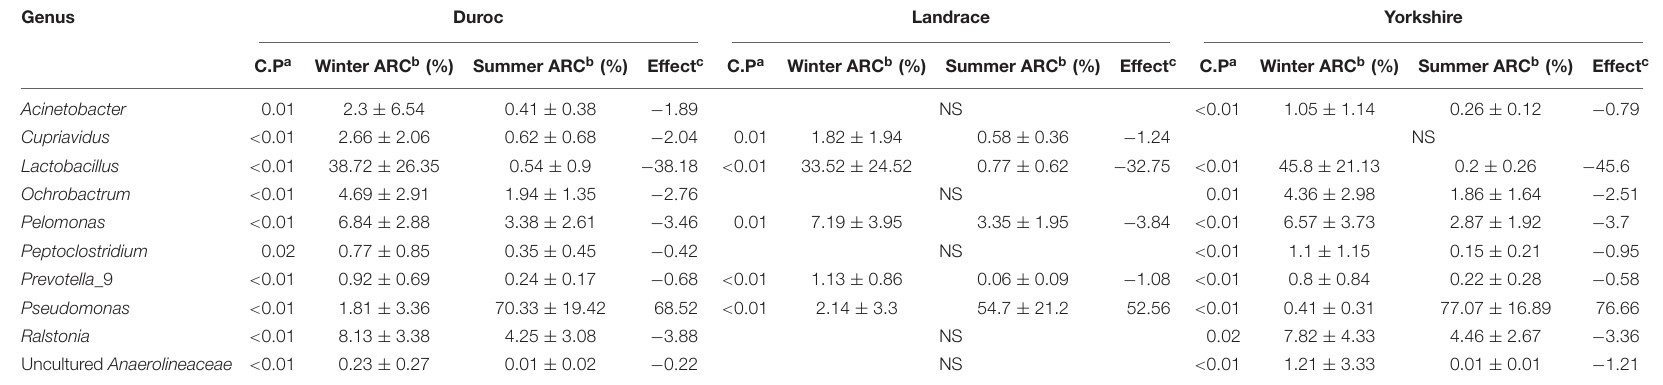
TABLE 2 | Semen bacteria with different abundance at genus level in winter and